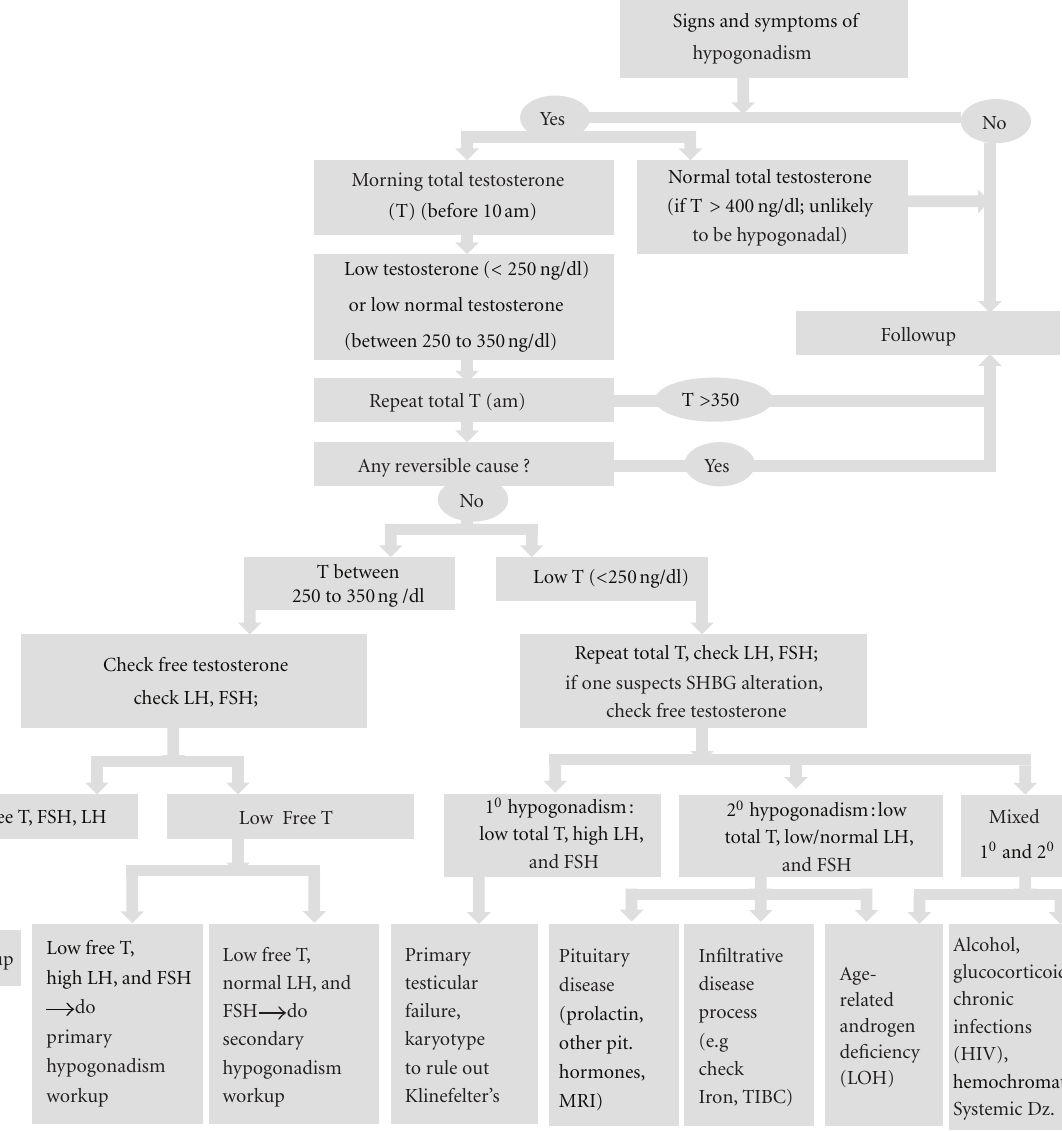
Figure 1: Algorithm for the diagnosis of hypogonadism in aging